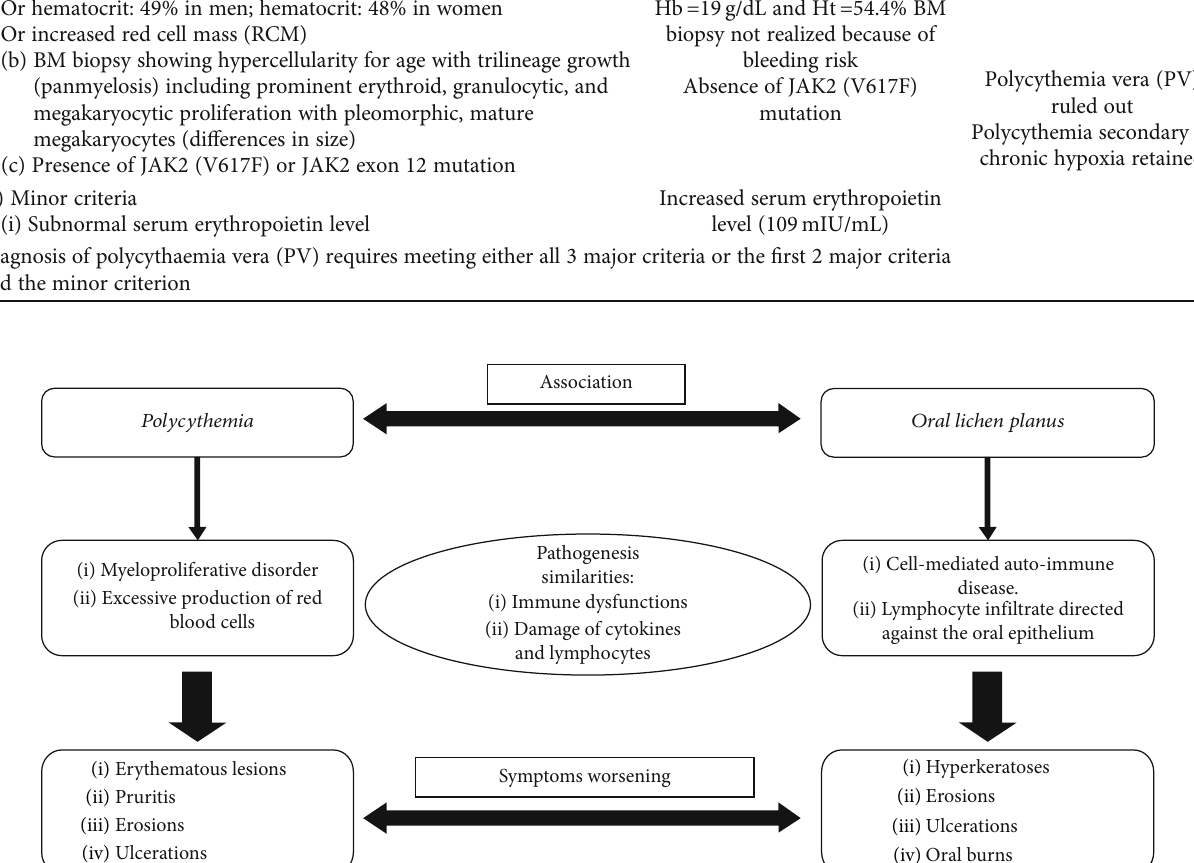
Figure 6: A proposal of an explanation of the association of oral lichen planus and